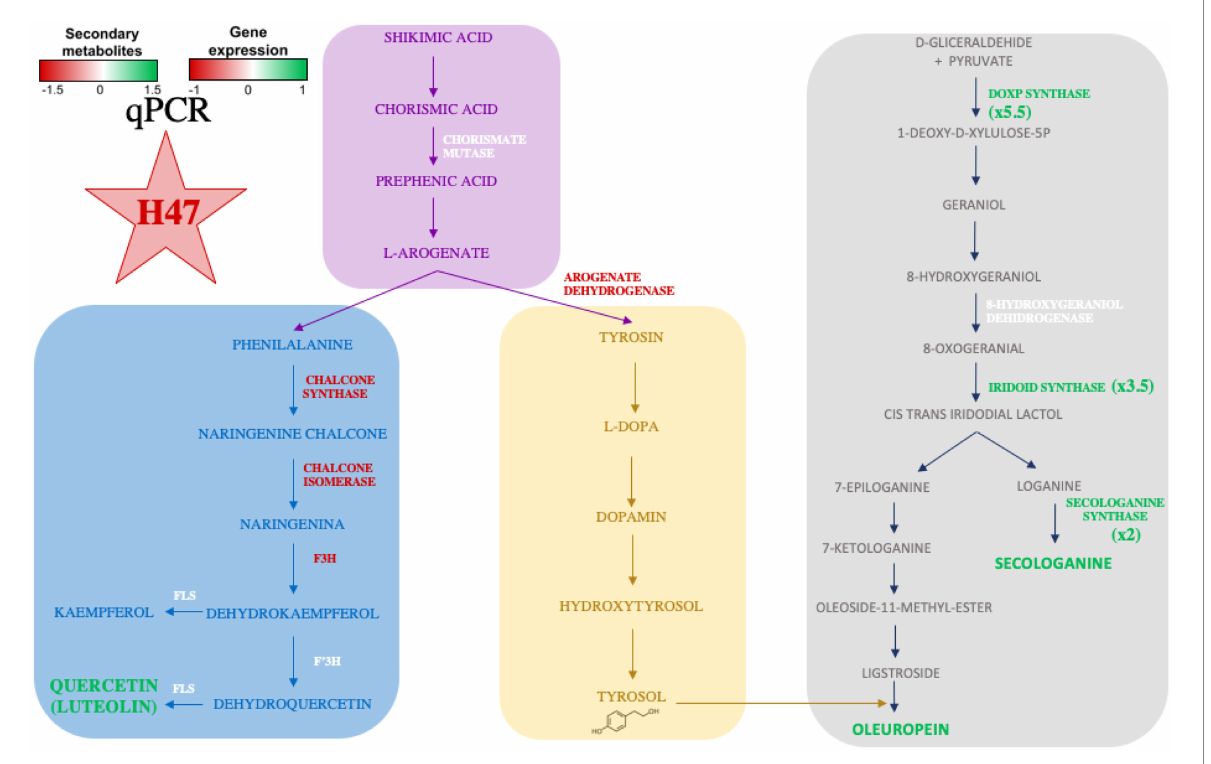
FIGURE 8 Representation of the shikimate-flavonol pathway, the phe and tyr branches leading to main flavonols or tyrosol, respectively and DOXP-pathway with studied enzymes. Names of enzymes (and metabolites) in green indicate higher concentration/expression, in red are lower and in white do not